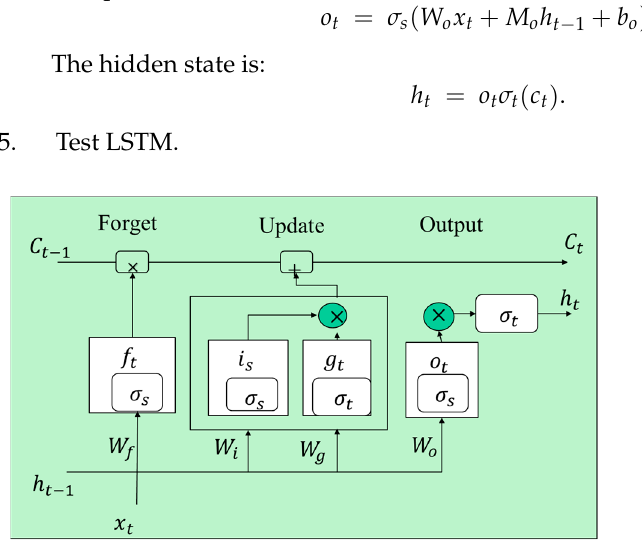
Figure 3. Long short-term memory.